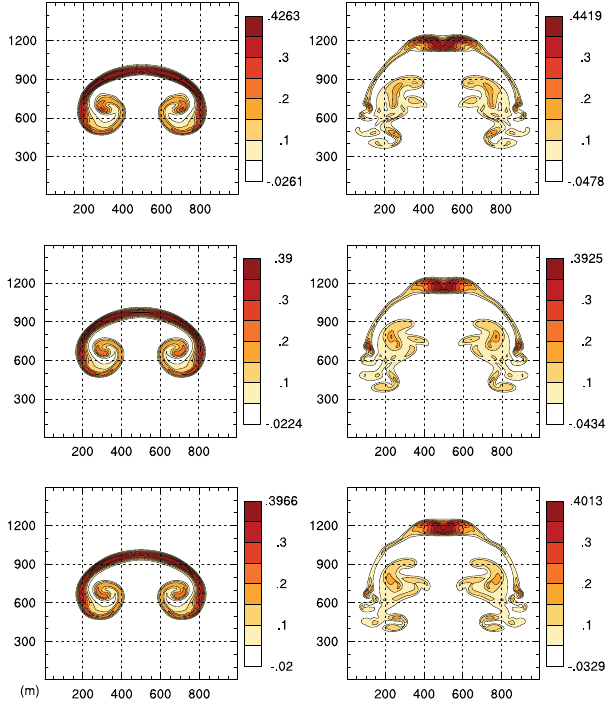
Figure 19. Rising Robert bubble potential temperature at vertical orders 2, 4, and 10. Convection bubbles at 800 at 1200s. Coarse, evaluation resolution (cid:49)x = 10m and (cid:49)z = 10m. Extrema in θ shown. Contour interval: 0 . 05K.